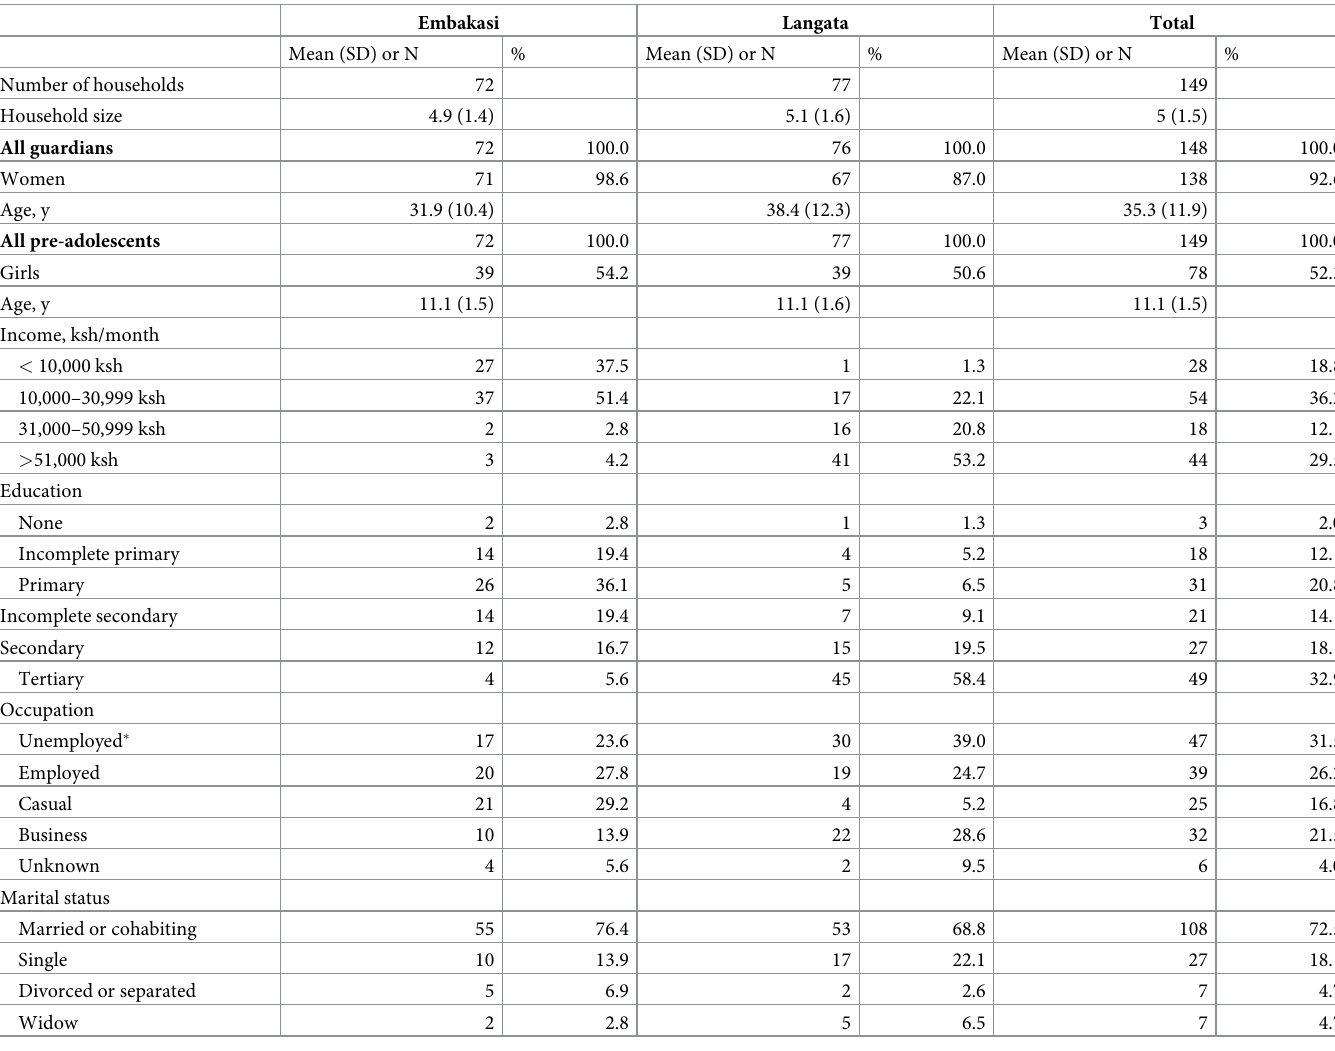
Table 1. Sociodemographic characteristics of participants (9–14 years old pre-adolescents [n = 149] and their guardians [n = 148]) in Embakasi and Langata,